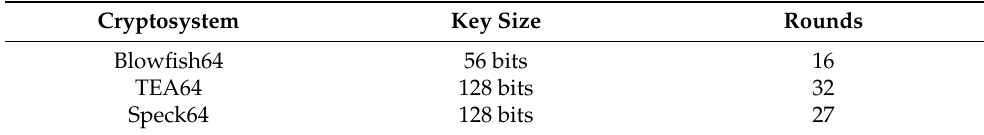
Table 1. Test Parameters for the Considered